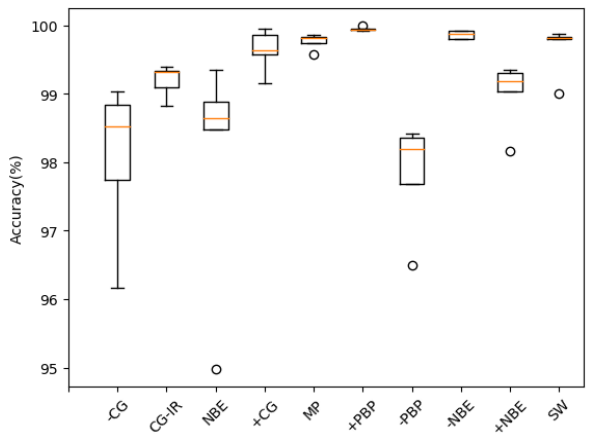
Sensors 2020 , 20 , x FOR PEER REVIEW Figure 6. Box plot of model classification accuracy. Figure 6. Box plot of model classification accuracy. Table 2. Five-fold cross-validation for different types of classification accuracy.